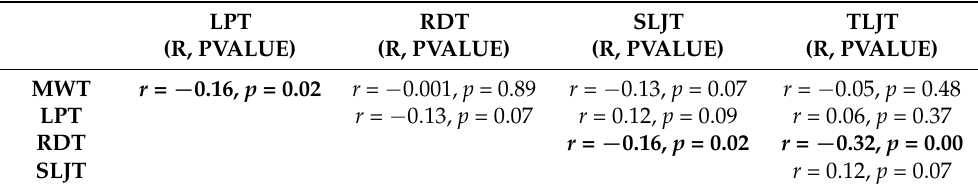
Table 4. The table reports the Pearson product-moment correlation coefficients (r) between the different tasks. Statistically significant r values are in bold. MWT = mental walking task; LPT = landmark position task; SLJT = spatial length judgment task; TLJT = temporal length judg- ment task; RDT = route drawing